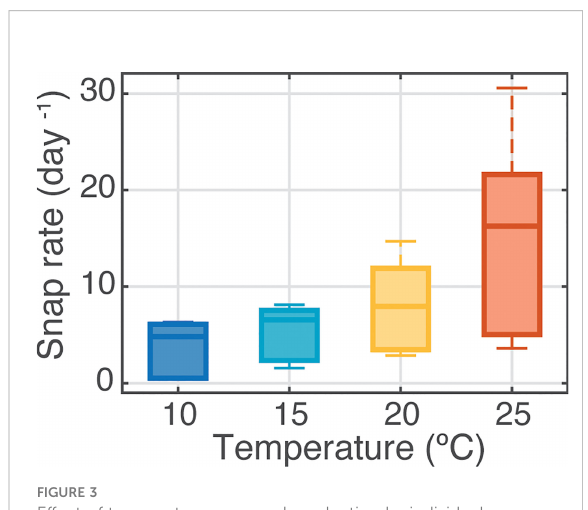
FIGURE 3 Effect of temperature on sound production by individual snapping shrimp Alpheus heterochaelis (n = 6 per treatment) in Experiment 1. Box plots show median values (solid horizontal lines), 50 th percentile values (box outline), and 90 th percentile values (whiskers) of snap rate (per day). Fitting a linear regression model of these data showed a signi fi cant effect of temperature (r 2 = 0.32, F 1,22 = 9.28,